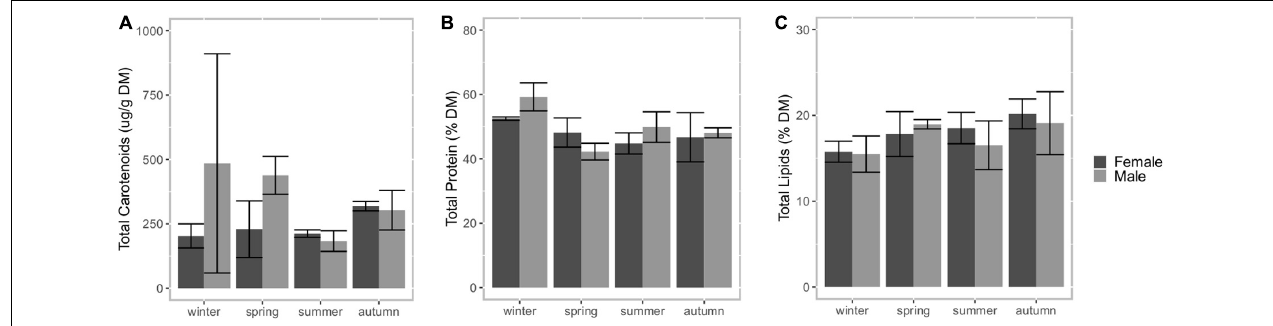
FIGURE 7 | Total carotenoids [ (A) , mg/g dry matter DM], crude protein [ (B) , % DM] and total lipids [ (C) , % DM] present in female and male gonads of Sphaerechinus granularis by season in Madeira archipelago.